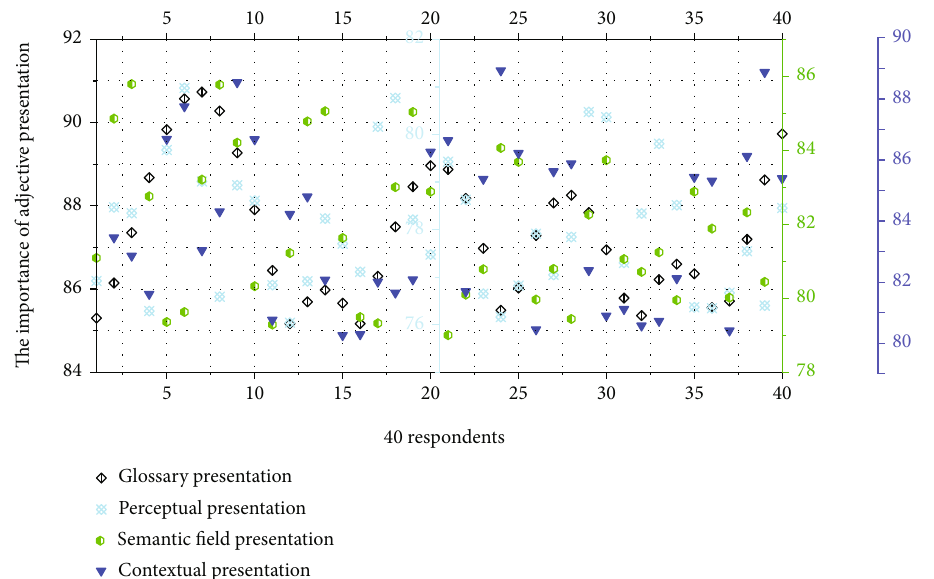
Figure 3: Quantitative assessment of the importance of adjective